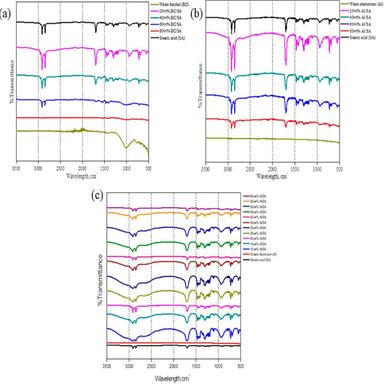
FTIR spectra for series of waste composite for (a) carbon BC and (b) recycled Al powder (c) recycles Al powder of mass loading less than 60 wt%.